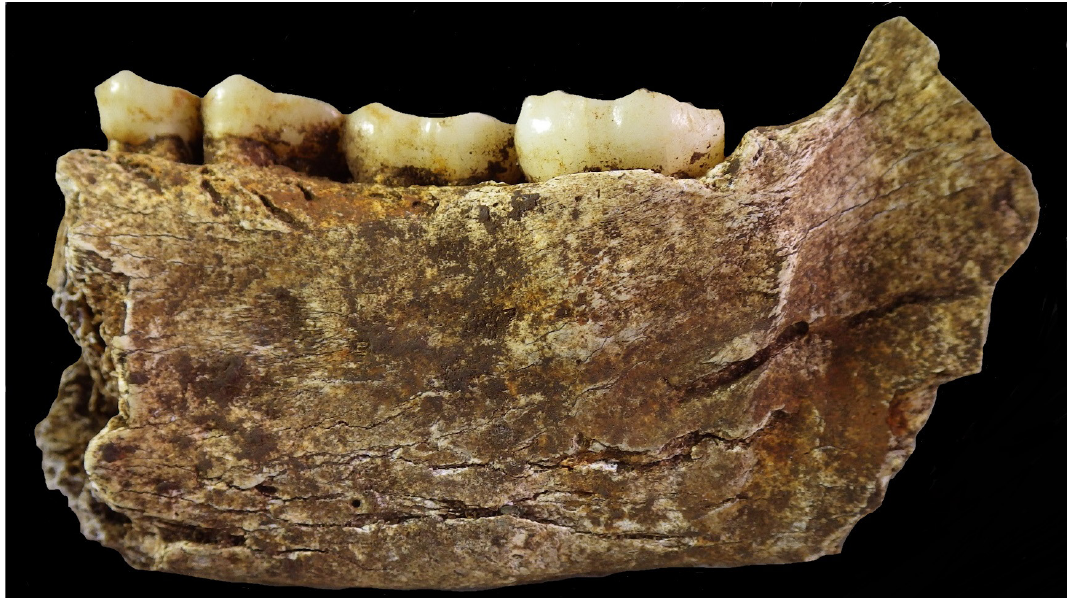
One of the mandibles of Homo naledi shortly after recovery from the Dinaledi Chamber. Note the excellent state of preservation and the cave sediment still adhering to the specimen. The network of cracks visible across the body and ramus of the mandible were caused by compression of the bone by sediment, and cycles of repeated wetting and drying of the bone within the